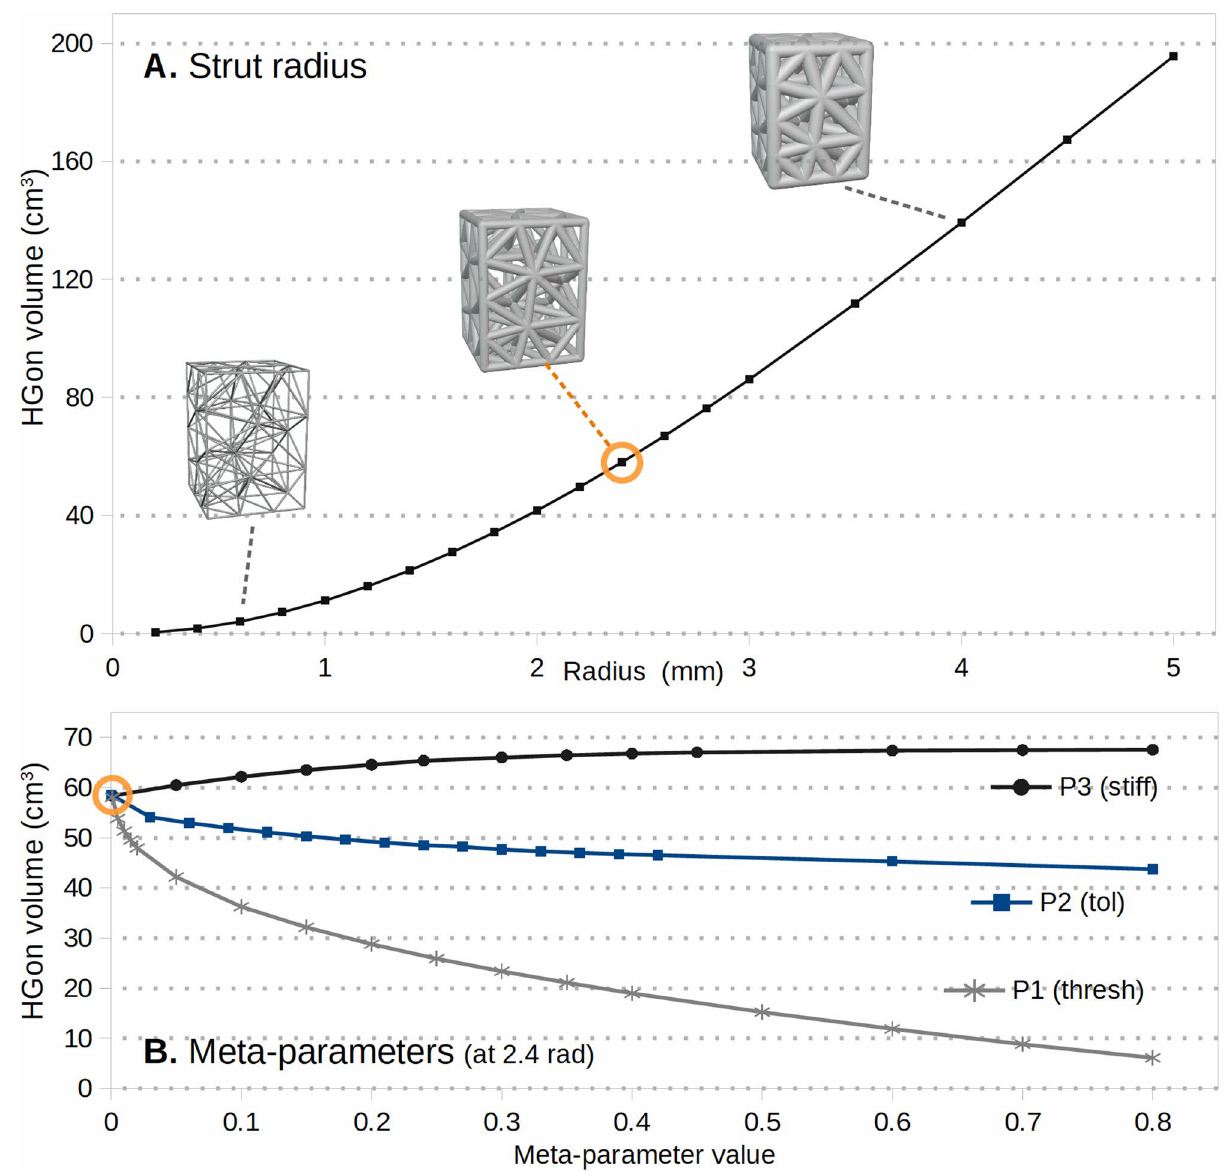
Figure 7. Plots of the variations in total HGon volume versus meta-parameter ( A ) strut radius, which has the most overall effect and ( B ) three other primary meta-parameters: P1-threshold, P2-tolerance/influence, and P3-stiffness. The meta-parameters are computed from a base 2.4 mm strut radius as indicated by the circles (co-indicated in Fig. 6 for